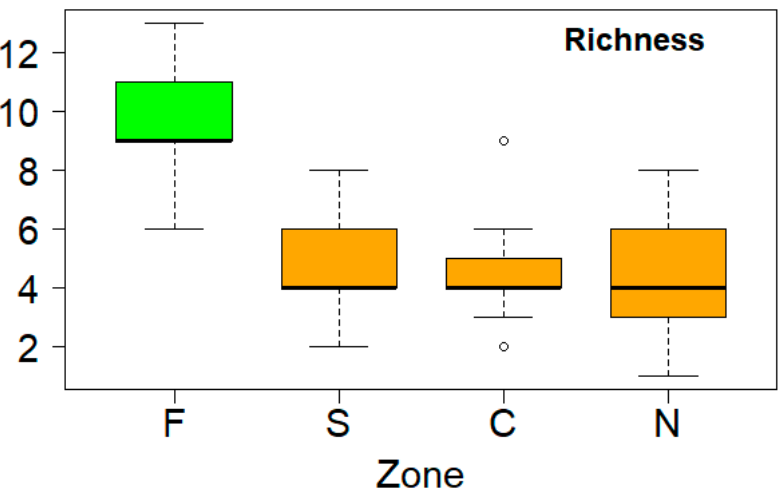
Figure 3. Boxplot of bryophyte species richness at different zones along the Zamora river. Different colors correspond to post hoc Tukey groups ( p < 0.05) after a GLMM. Control zone (F); south zone (S); center zone (C); and north zone (N).